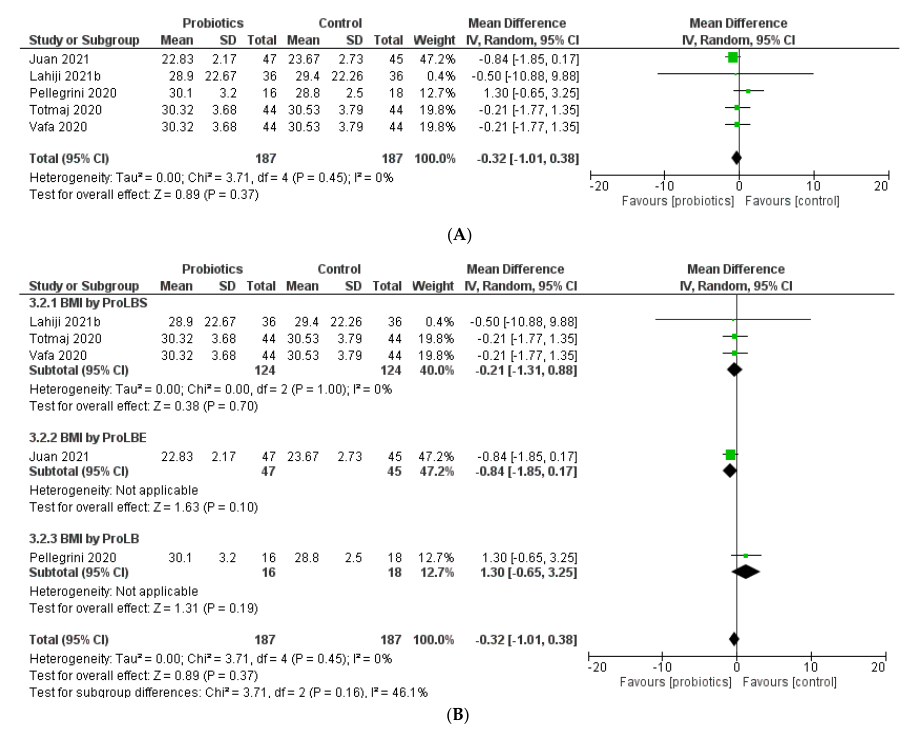
Figure 3. Meta-analysis forest plot for ( A ) body mass index (BMI) and ( B ) BMI by probiotic type.